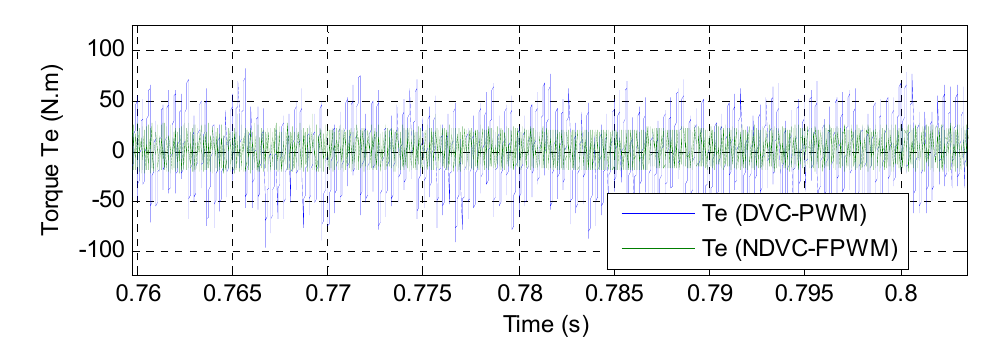
Figure 22. Zoom in the torque.